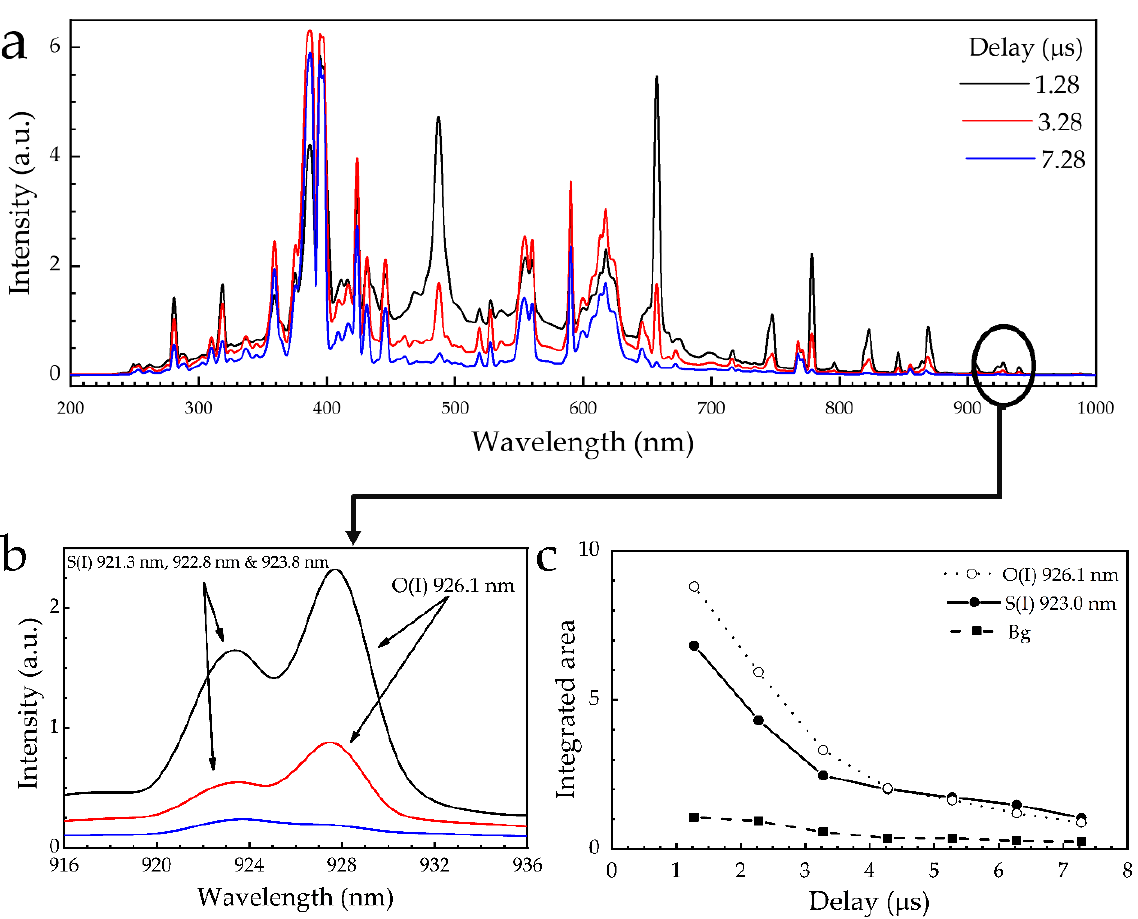
Figure 6. Effect of the time delay, t d , on: ( a ) the LIBS spectra of a soil-sulfur sample, ( b ) the sulfur spectral lines at around 923.0 nm (corresponding to a zoom of the black circle in (a)), ( c ) the peak intensities of the S(I) (black) and O(I) (blue) spectral lines and the corresponding background (red).